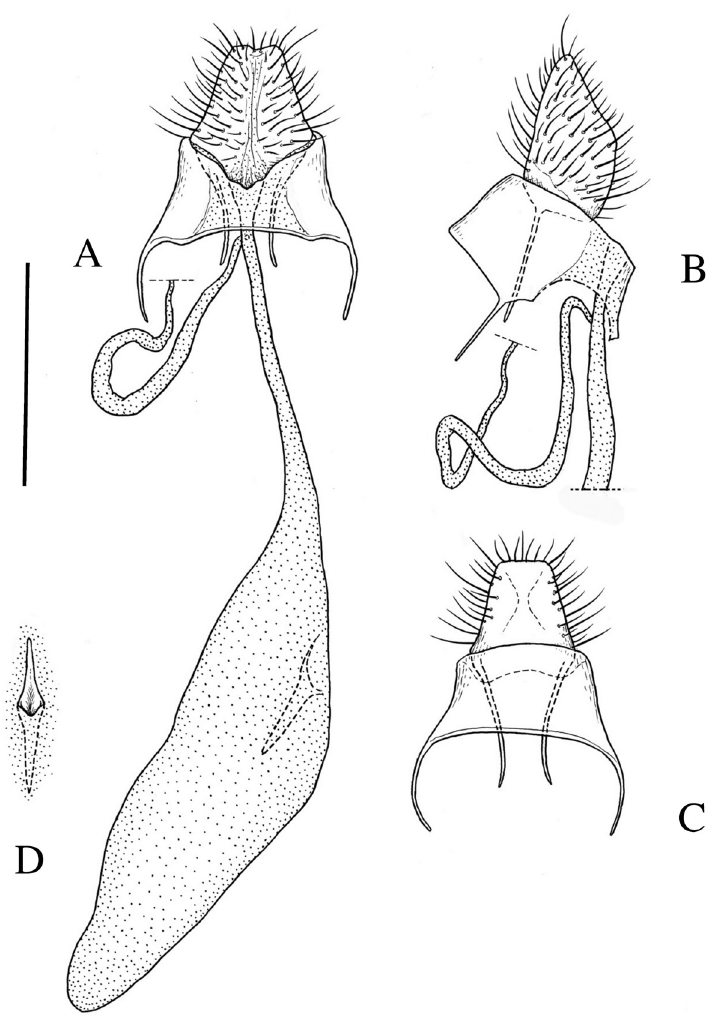
Figure 3. Female genitalia of Roeslerstammia metaplastica Meyrick, 1921, paralectotype. A Terminalia and bursa copulatrix, ventral view B Terminalia, lateral view C Ditto , dorsal view. D Signum. Scale bar: 0.5